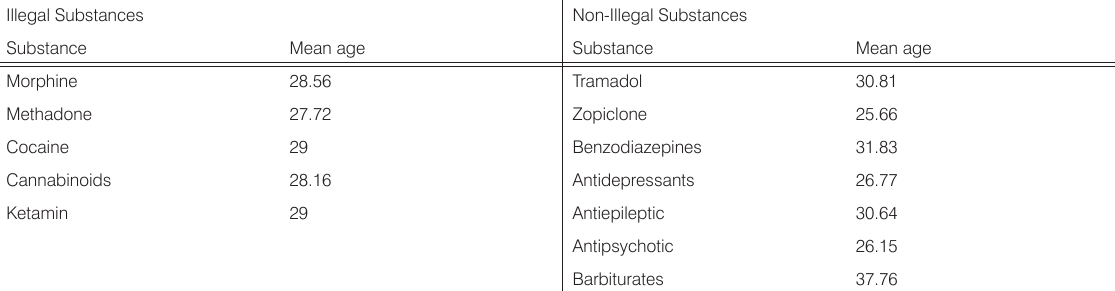
Table 4. Mean age at the moment of death in various DRDs Illegal